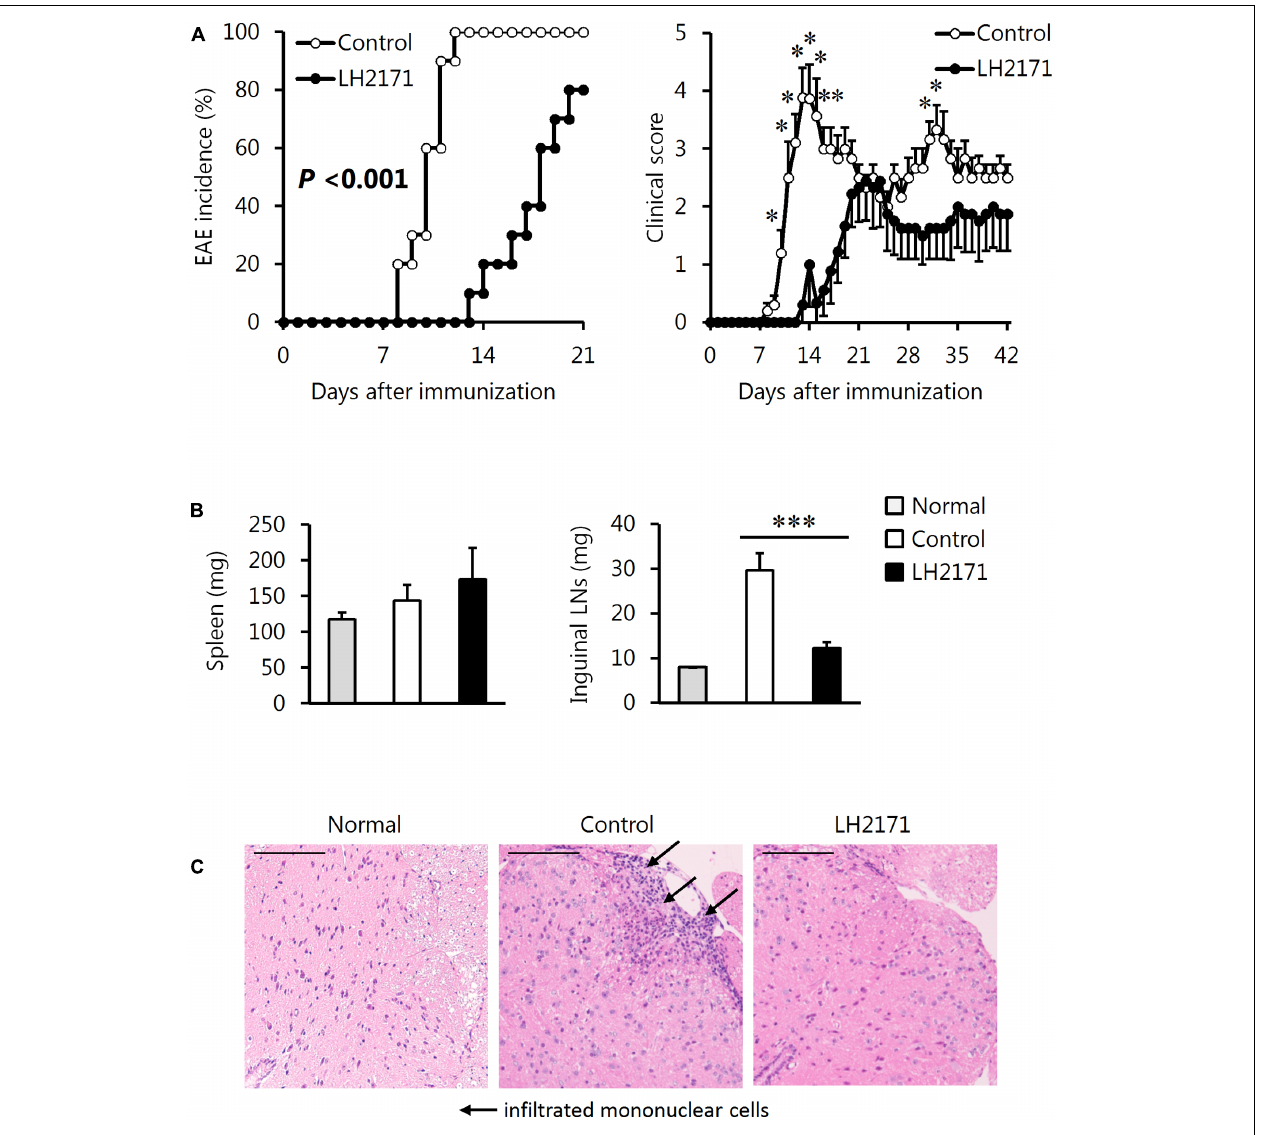
FIGURE 2 | Alleviative effects of LH2171 on the incidence and symptoms of EAE in mice. EAE was induced in SJL/J mice by immunization with a major myelin protein; proteolipid protein. Mice were intraperitoneally injected with either LH2171 or PBS as a vehicle (control). (A) After the immunization, mice were observed for measurement of EAE incidence and clinical score. On day 42 after immunization, the spleen, inguinal LNs, draining LNs in this study, and spinal cord were collected from EAE mice; the weights of the spleen and LNs (B) were measured. Data are shown as means ± SEM (normal group, n = 3; control group, n = 10; LH2171-administered group, n = 10). The EAE incidence between LH2171-administered mice and control mice was compared with the log-rank test, and the clinical store and tissue weight were compared between groups with Student’s t -test ( ∗ P < 0.05, ∗∗∗ P < 0.001). (C) The spinal cord sections obtained from the mice on day 42 after immunization were analyzed by haematoxylin and eosin staining. Scale bar = 100 µ